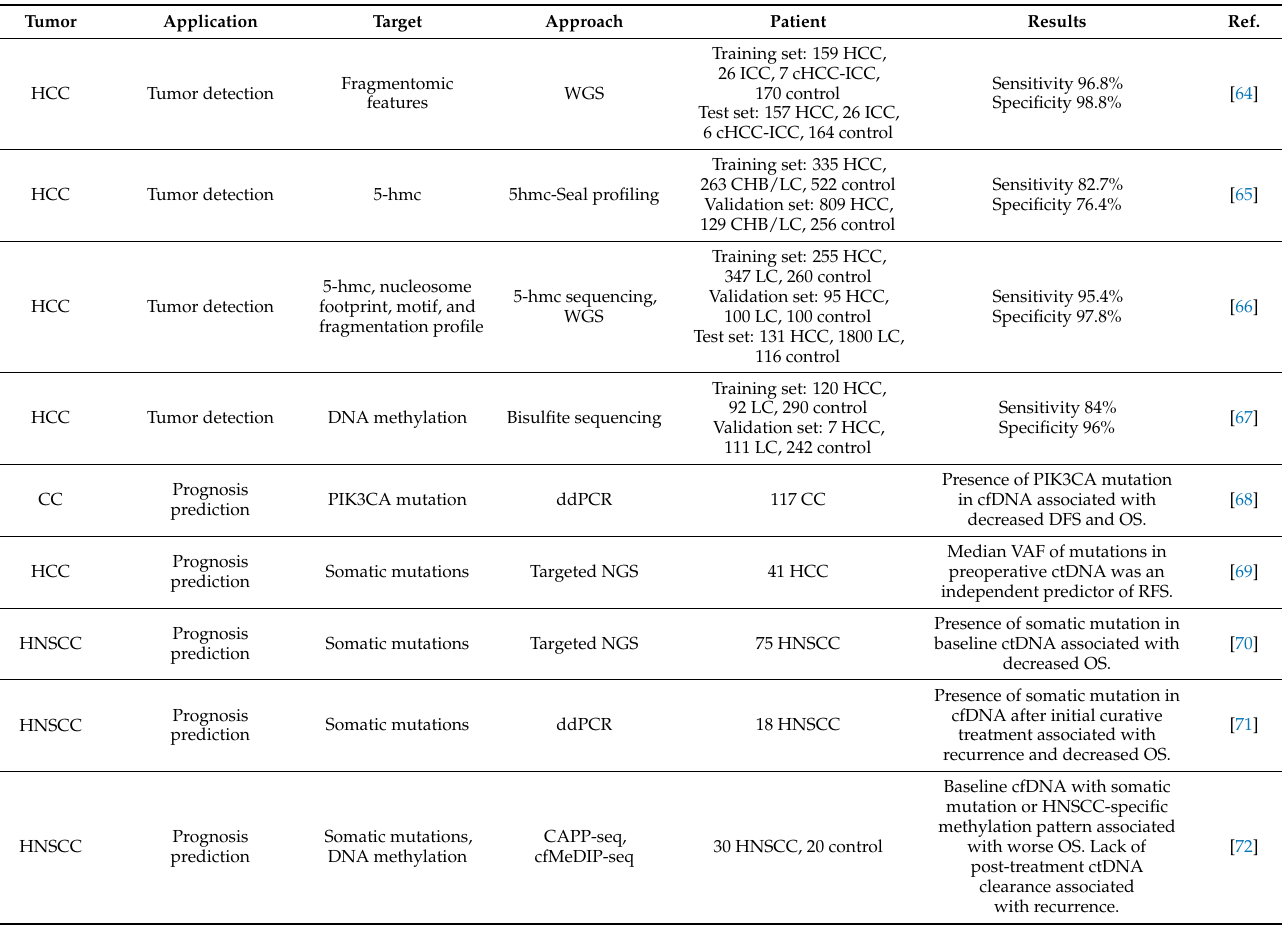
Table 1. Applications of ctDNA in virus-related